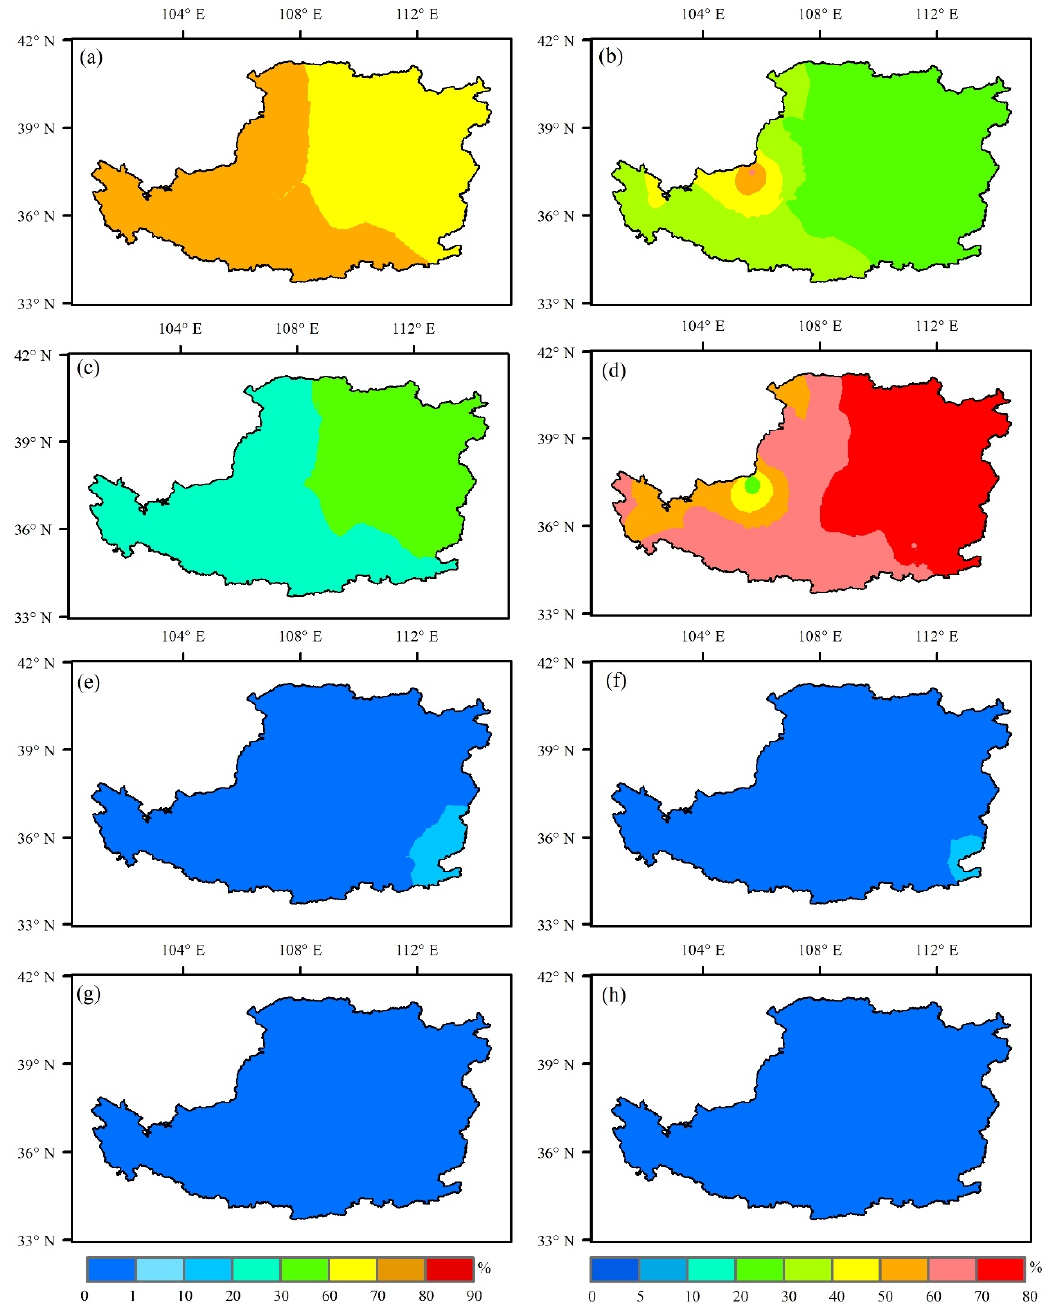
Figure 7. Spatial distribution of the (left column) incidences and (right column) contribution rates in ( a , b ) light rainfall; ( c , b ) moderate rainfall; ( e , f ) heavy rainfall and ( g , h ) rainstorm, respectively.